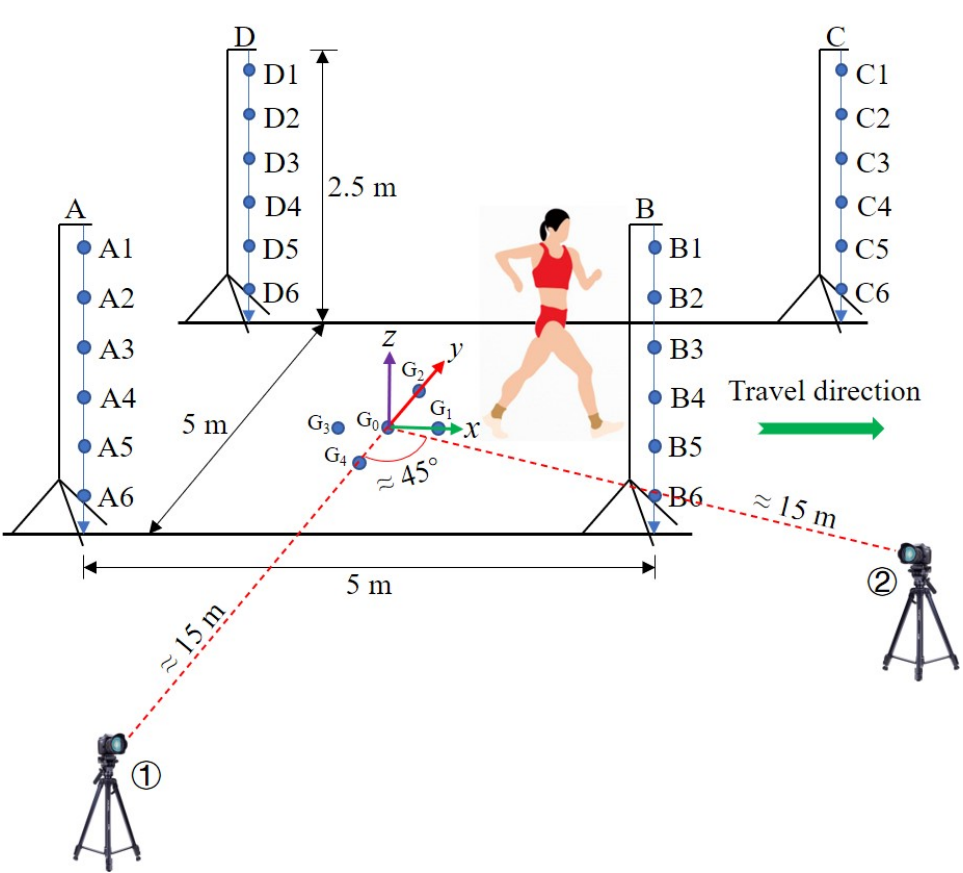
Figure 2. Setup of calibration space and geodetic coordinate system. A1~A6, B1~B6, C1~C6, and D1~D6 are calibration mark points; G1~G5 are landmark points of ground coordinates.